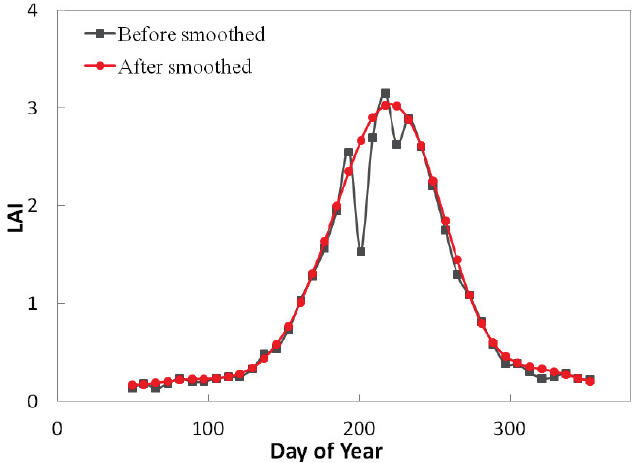
Figure 6. HANTS smoothing of the LAI time series